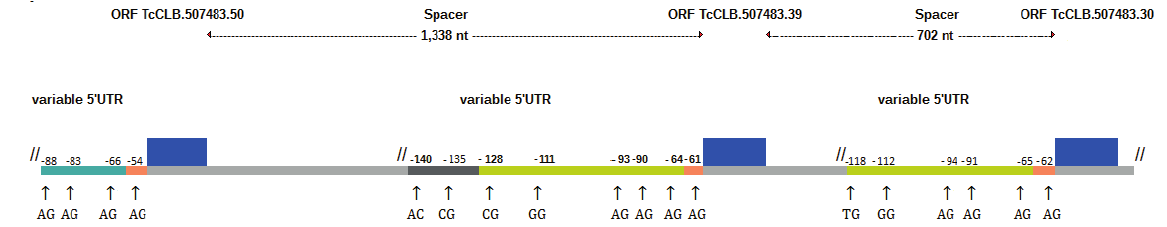
Figure 1 - Diagram of T. cruzi calmodulin locus and frequency of the mRNA variant sequences. The locus displays three tandem copies that are separated by two intergenic segments of 1,338 and 702 nt. Blue box: ORF; colored bars: 5’ UTR that results from the multiple trans splicing sites as detected in epimastigote stage; in orange and yellow are the 5’ UTR segment common to three or two copies, respectively. Arrows and numbers at left of the blue box indicate the approximate position of the trans splicing site (and the respective dinucleotide below the arrows), which also define the beginning of 5’ UTR in the genome for each mRNA